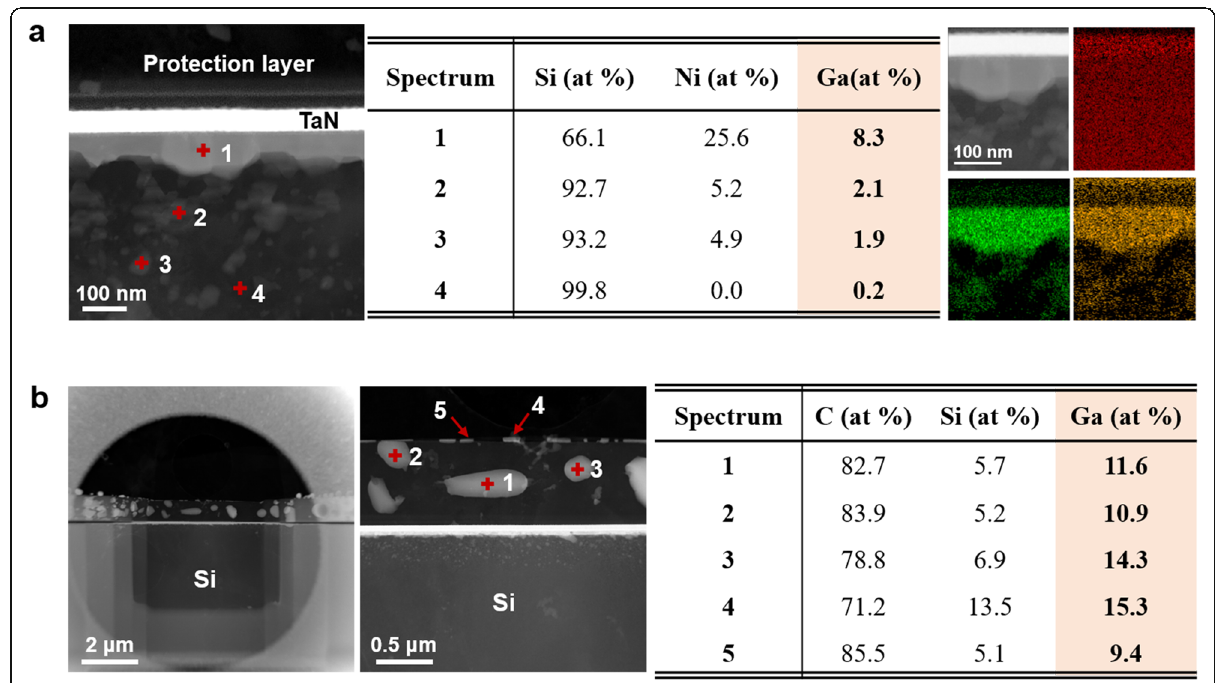
Fig. 3 Results after the specimen in the trench is subjected to Ar + ion milling. a The HAADF-STEM image and the results of the EDS analysis of the heat-treated graphene-encapsulated TaN/Ni/Si thin-foil specimen. The Si K series, Ni K series, and Ga L series EDS mapping is shown in red, green, and orange, respectively. b The HAADF-STEM image and chemical composition of the heat-treated graphene-encapsulated TaN/Er/Si thin-foil